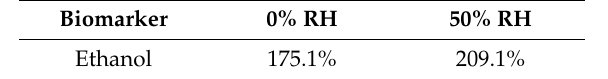
Table 5. Percentage variation between 0.5 and 2 ppm of ethanol, both at 0% RH and 50% RH.